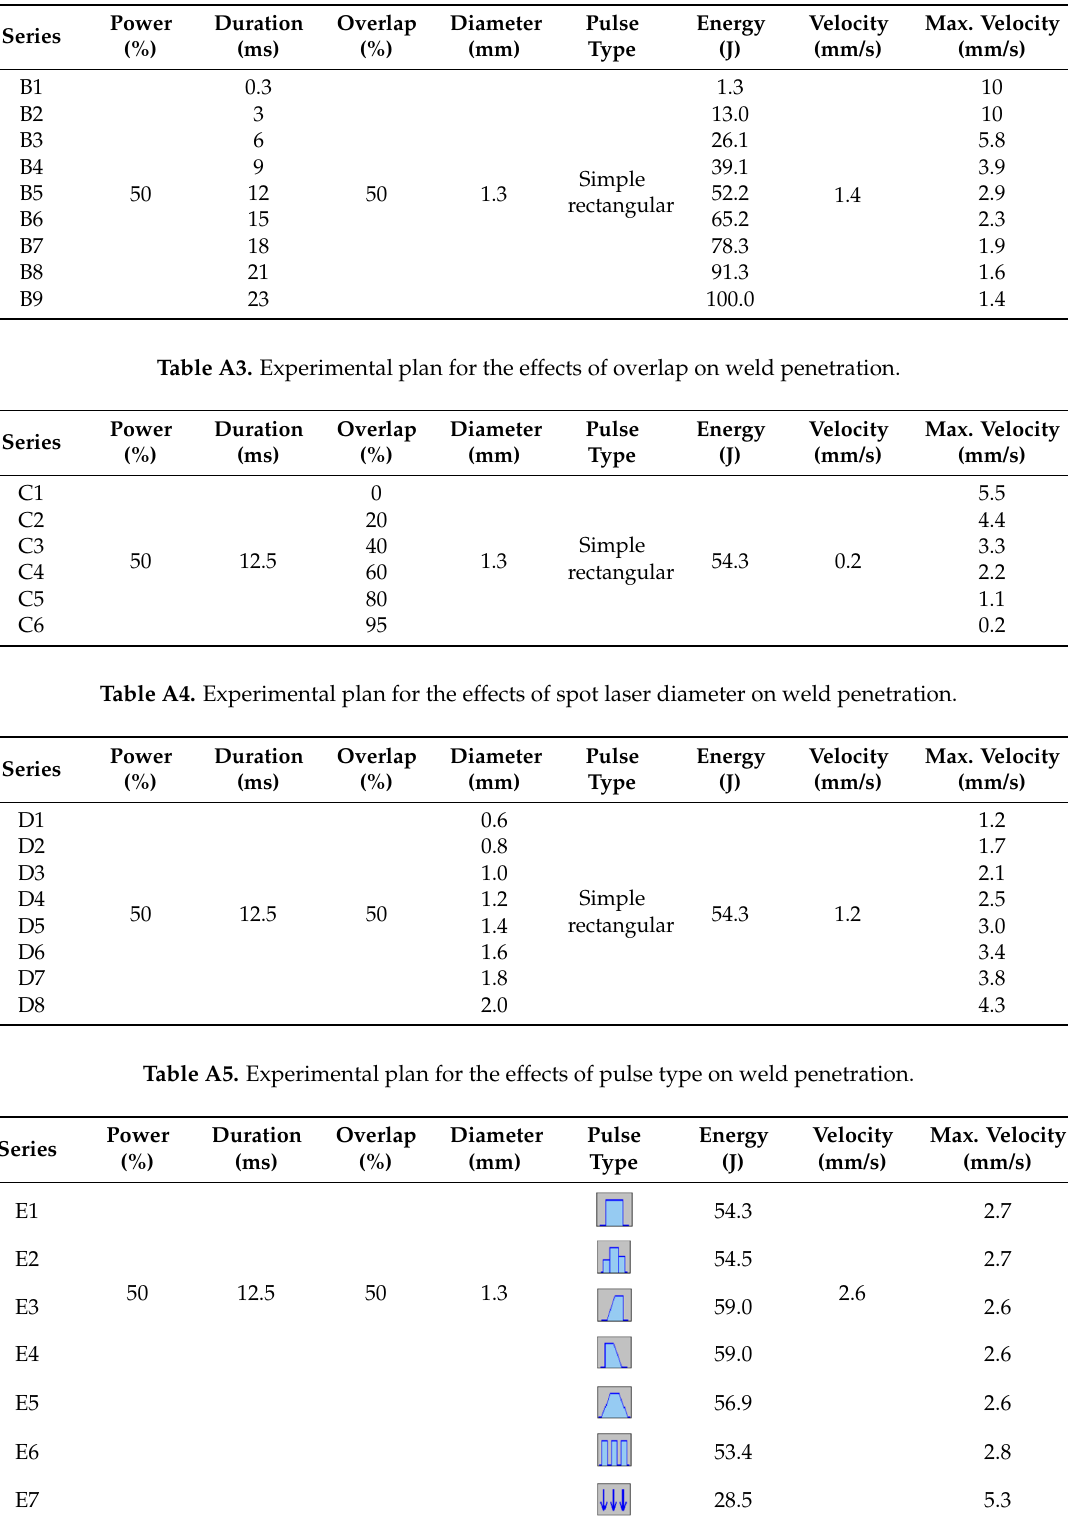
Table A2. Experimental plan for the effects of pulse duration on weld penetration.